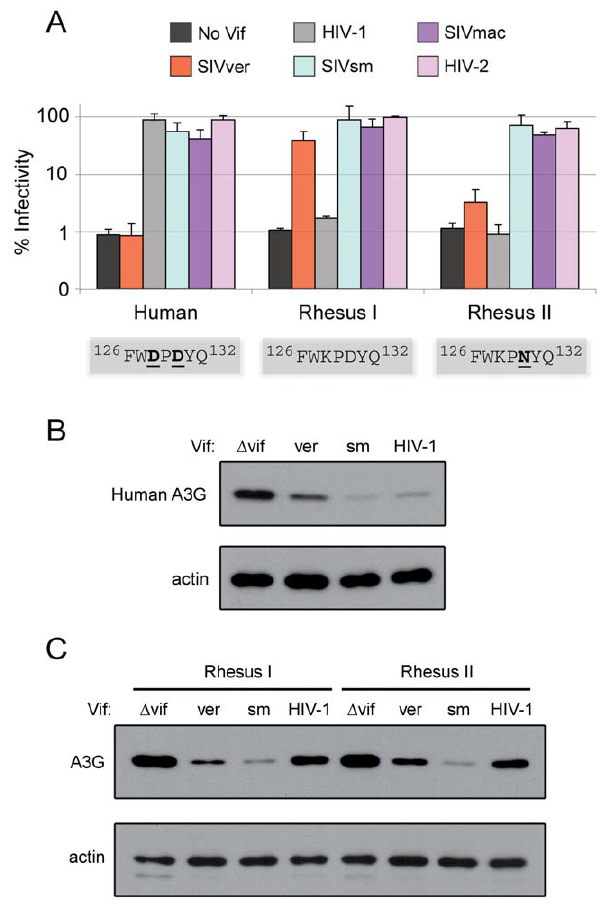
Figure 3. Broad and potent activity of Vif from SIVsm and its descendants allow antagonism of rhesus and human A3G variants. Single-round infectivity assays were performed with HIV- 1 D Vif and HIV-1 expressing SIV Vif proteins produced in the presence of A3G variants from human and rhesus macaques (A). Infectivity of viruses is reported as a percentage, relative to infectivity in the absence of A3G (100%). Error bars indicate standard deviation from the mean of two independent transfection experiments (six infection replicates in total). The Vif binding site of each A3G variant is depicted in grey boxes. The primate A3G gene used is listed under the graph, while the source of the Vif genes were either no Vif (black box), SIVagm.ver (orange), HIV- 1 (grey), SIVsm (light blue), SIVmac (dark purple), or HIV-2 (light purple). Anti-HA western blot analysis was used to measure human A3G expression in (B) and rhesus A3G expression in (C). Anti-ß-actin served as protein loading controls.